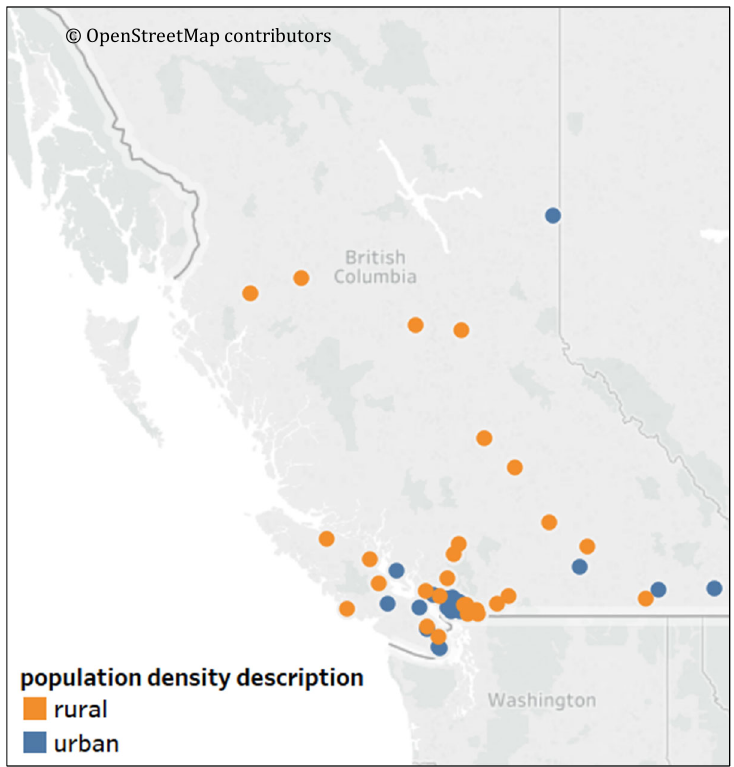
Figure 1. Distribution of British Columbia Municipalities with Official Community Plans (OCPs) Included in the Analysis Rural municipalities (population density < 400 people/km 2 ) are in blue and urban municipalities (population density ≥ to 400 people/km 2 ) are in